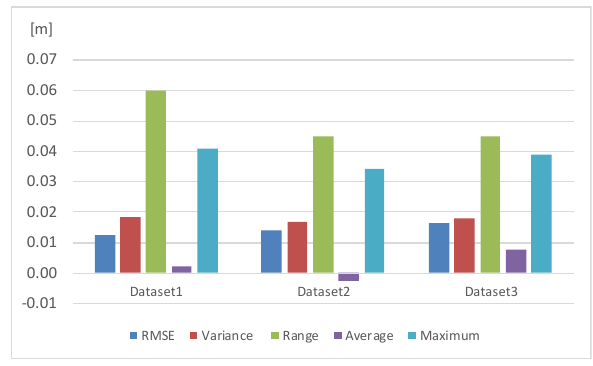
Figure 4. Results of the evaluation at 100 m